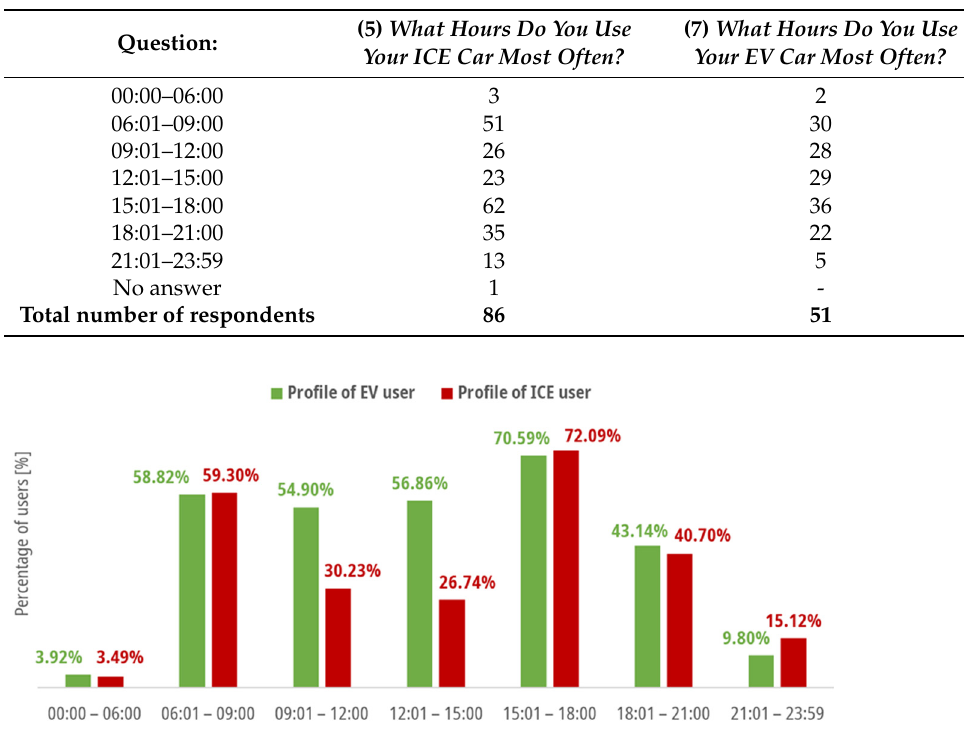
Table A5. Detailed responses to questions (5) and (7)—multiple-choice.